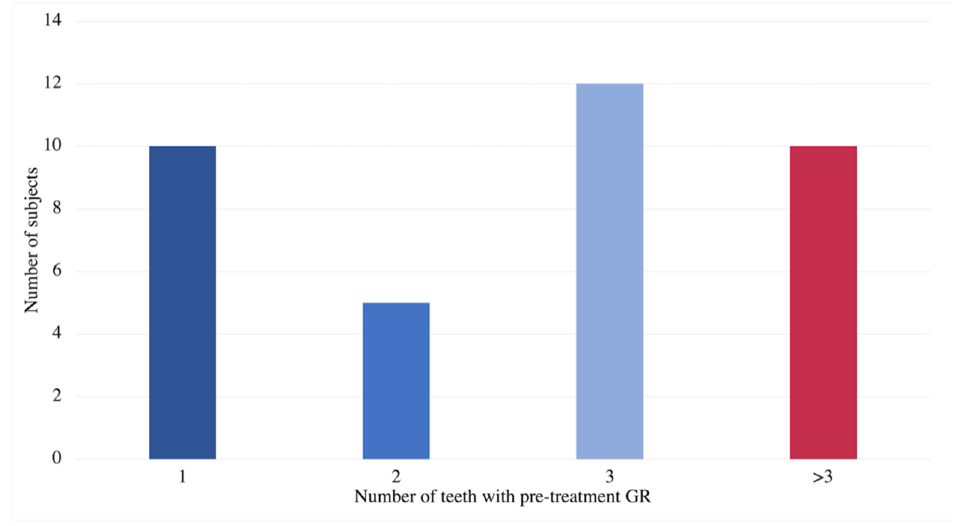
Figure 4. Distribution of the number of teeth with pre-treatment gingival recessions in 37 patients. Mean GR after OT reduced to 1.11 mm (CI: 0.89, 1.33). Significant improvement of mean GR was found between T0 and T1 (0.45 mm, CI: 0.28, 0.62) ( p = 0.001). Ten patients had no improved GR, 9 patients had 1 improved GR, 9 patients had 2 improved GRs, 3 patients had 3 improved GRs, 2 patients had 4 improved GRs, 3 patients had 5 improved GRs and one patient had 8 improved GRs. In 51.4% of patients GRs became better, in 37.8% GRs did not change and in 10.8% GRs became worse. Change of gingival recessions after OT at a patient level is shown in Figure 5.